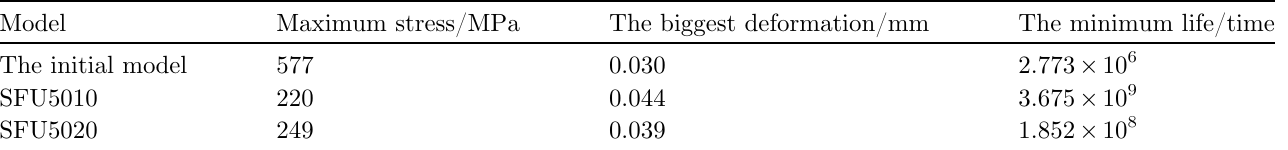
Table 6. The simulation results of each model were compared. Model